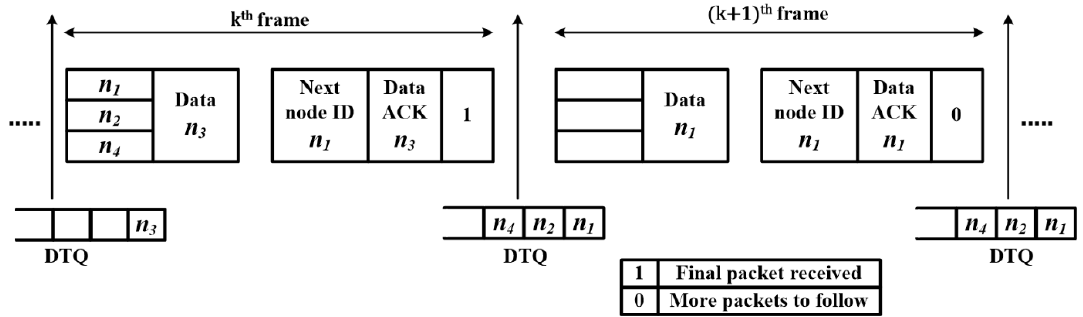
Figure 4. OrMAC operation between two consecutive frames.